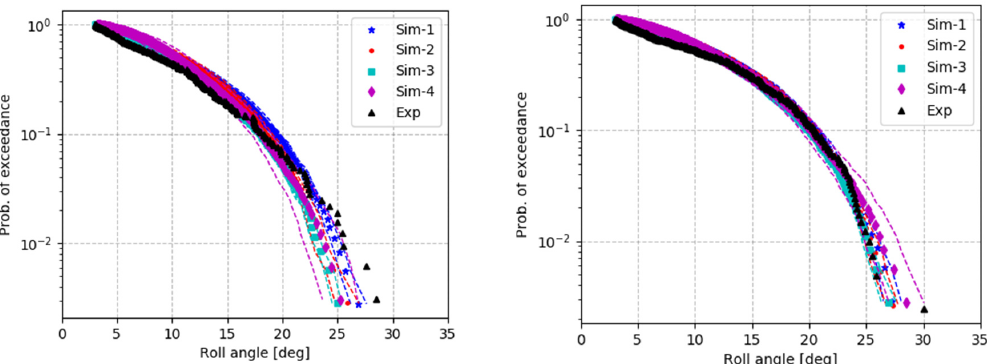
Figure 7. Extreme value distributions of the roll motions from the four programs and experiment. The mean (markers) and the 95% confidence interval (dashed lines) obtained from 10 realisations of the wave are shown for the simulations. Durations of the experiment and each realisation in the simulations are 3 h. Left: Head waves, Hs = 7 m, Tp = 13.5 s, speed vs. = 7.6 kn. Right: Head waves, Hs = 8 m, Tp = 13.5 s, speed vs. = 7.9 kn.